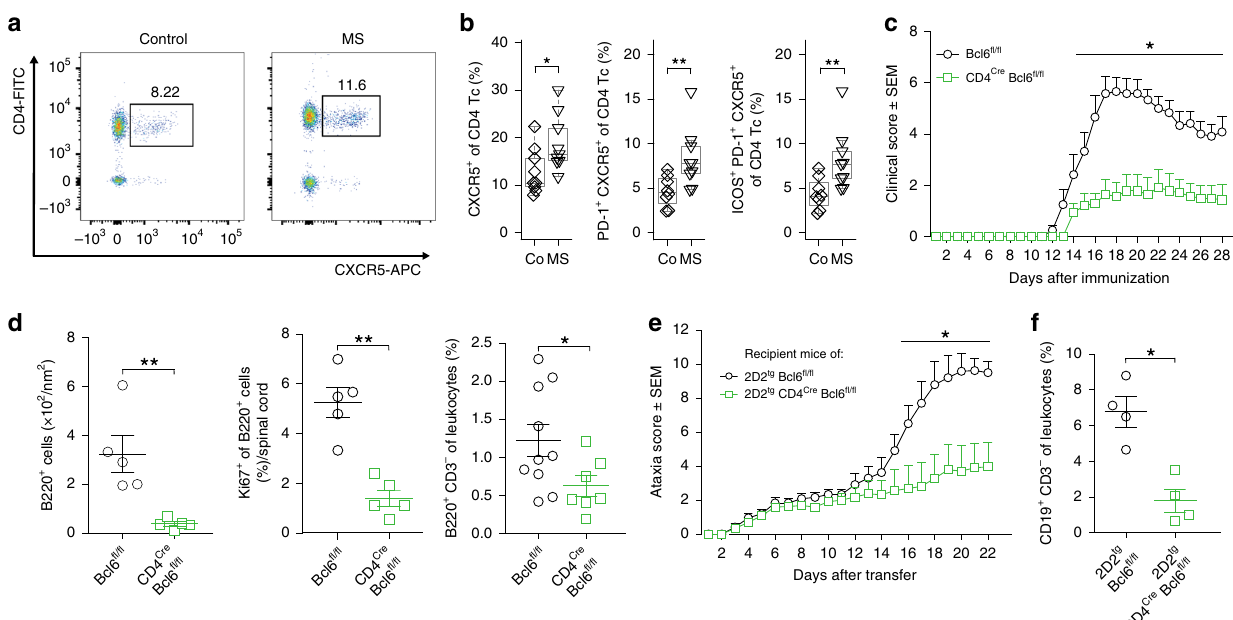
Fig. 4 TFH cells expand in the CSF in MS and promote MS animal models. a Representative fl ow cytometry dotplot of CSF cells from a control and MS patient after gating on live CD3 + cells. Gating and sorting strategy is depicted in Supplementary Fig. 10a. b Proportion of CXCR5 + (left), of PD-1 + CXCR5 + (middle), and of ICOS + PD-1 + CXCR5 + (right) cells among live CD3 + CD4 + T cells in CSF of control (co; n = 9) and MS ( n = 9) patients quanti fi ed by fl ow cytometry. c Active EAE was induced in Bcl6 fl / fl (wildtype, circles, n = 6) and CD4 Cre Bcl6 fl / fl (squares, n = 7) mice using MOG 35-55 peptide (Methods). Mice were monitored daily for clinical EAE signs. One representative of three independent experiments is shown. d At day 28 after EAE induction, the density of B220 + leukocytes was quanti fi ed in spinal cord paraf fi n cross sections by histology (left). The proportion of Ki67 + among B220 + cells was quanti fi ed (middle). The proportion of CD3 − B220 + cells was quanti fi ed by fl ow cytometry at peak of EAE (right). Gating strategy is depicted in Supplementary Fig. 16a. e Naive CD4 + T cells were sorted from Bcl6 fl / fl 2D2 tg mice (wildtype, circles, n = 6) and CD4 Cre Bcl6 fl / fl 2D2 tg mice (squares, n = 8), differentiated in vitro (Methods), and intravenously injected into wild-type recipient mice at 5 × 10 6 cells per mouse. Recipients were monitored for signs of EAE. One representative out of fi ve independent experiments is shown. f At day 28 after transfer, the proportion of CD3 − CD19 + leukocytes in brain and spinal cord was quanti fi ed by fl ow cytometry. Gating strategy is depicted in Supplementary Fig. 16b. Mann – Whitney U test, * p < 0.05, ** p < 0.01, *** p < 0.005. The lower and upper edges of the box plots represent the lower and the upper quartile, respectively, the horizontal line inside the box indicates the median, and the whiskers extend to the most extreme values within the 1.5 interquartile range of the lower/upper quartile. c – f show mean ± s. e.m., source data listing the fl ow cytometry results and the clinical scores are provided in the Source Data fi